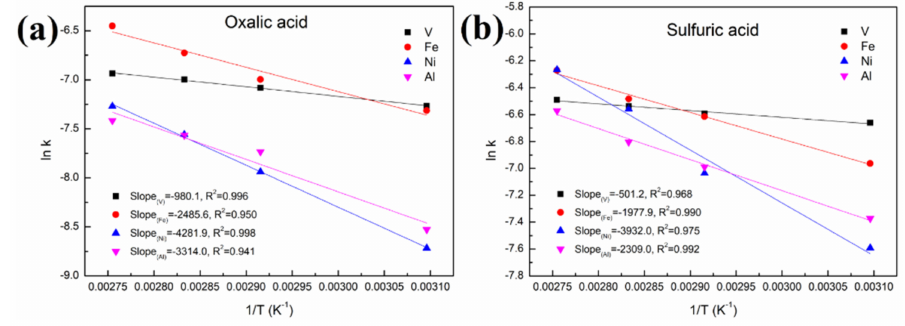
Figure 10. Linear fitting of (lnk) vs. (1/T) in ( a ) oxalic acid and ( b ) sulfuric